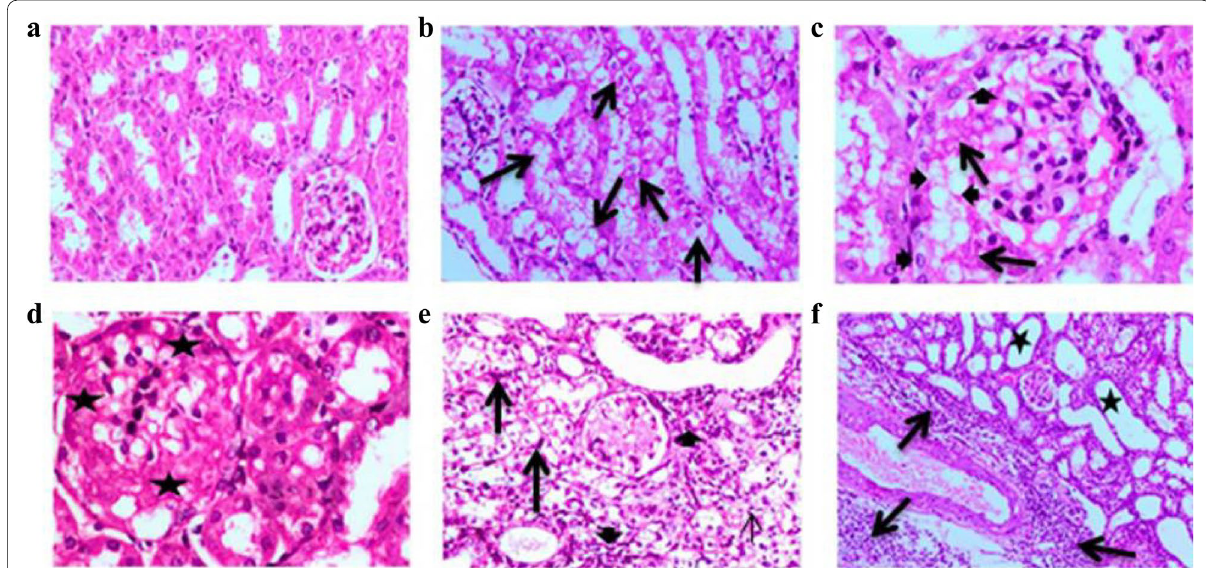
Fig. 1 a Kidney of normal control group, showing normal renal tubules and glomeruli; b kidney of obesity group showing vacuolar degenertion of epithelial lining of most of renal tubules (black long arrows); c kidney of obesity group showing dilatation of glomerular capillaries with partial hyalinization of glomerulus tuft (focal glomerular sclerosis) (black long arrow) and accumulation of glomerular foam cells (black short arrows); d kidney of obesity group showing severe glomerular hyalinization (glomerular sclerosis) (black stars) and vacuolation of glomerular tuft; e kidney of obesity group showing glomerular hyalinization (glomerular sclerosis), severe necrosis of renal tubules (black long arrows), cyctic dilatation of renal tubules, and interstitial fibrosis associated with inflammatoy cell infiltration (black short arrows); and f kidney of obesity group, showing marked cytic dillatation of renal tubules (black stars), massive perivscular agreggations of inflammatory cells (black long arrows), dilatation, and congestion of blood vessel (H&E, 100) ×